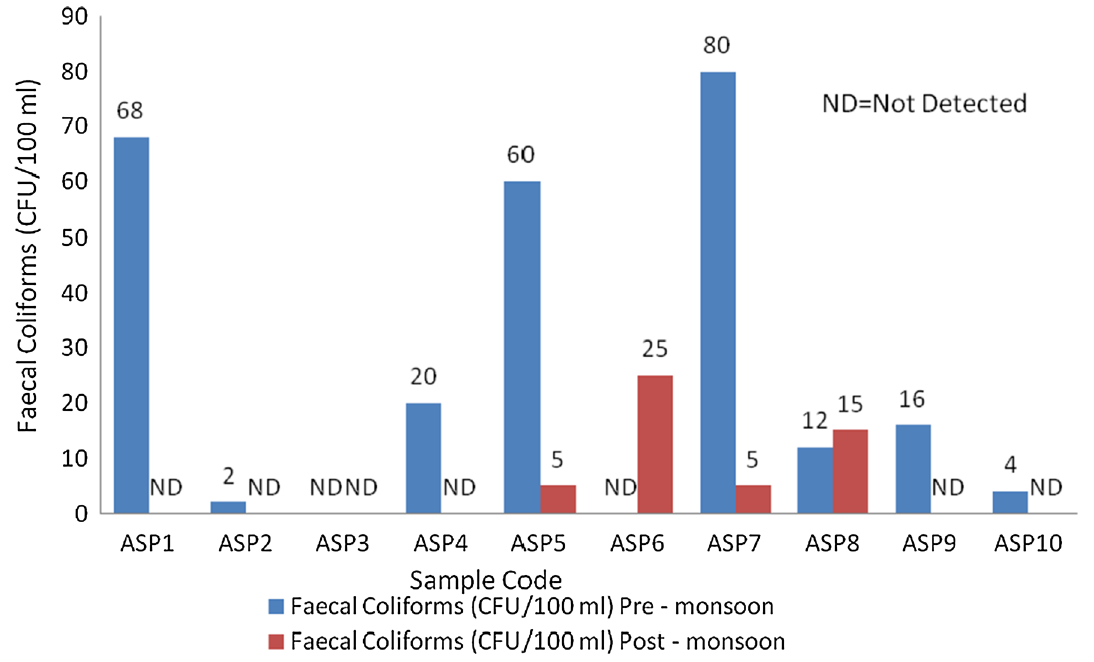
Fig. 16 Faecal coliforms in samples collected from Laxmi